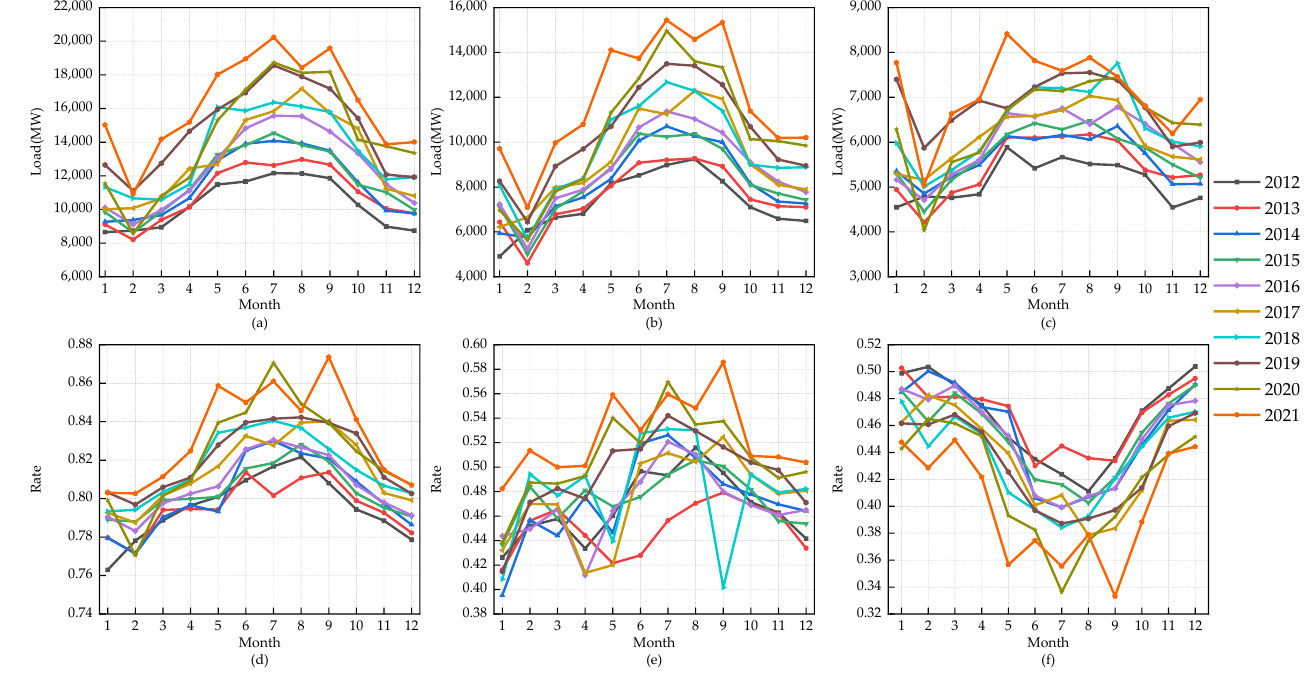
Figure 3. Change of monthly load characteristic indicators: ( a ) monthly peak load; ( b ) monthly average daily load; ( c ) monthly maximum peak – valley difference; ( d ) monthly average load rate; ( e ) monthly minimum load rate; ( f ) monthly average peak – valley difference rate.